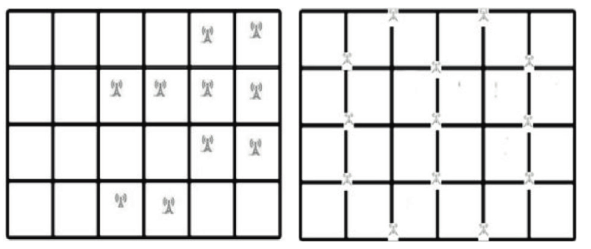
Figure 19: Optimal solution and delta-dimension